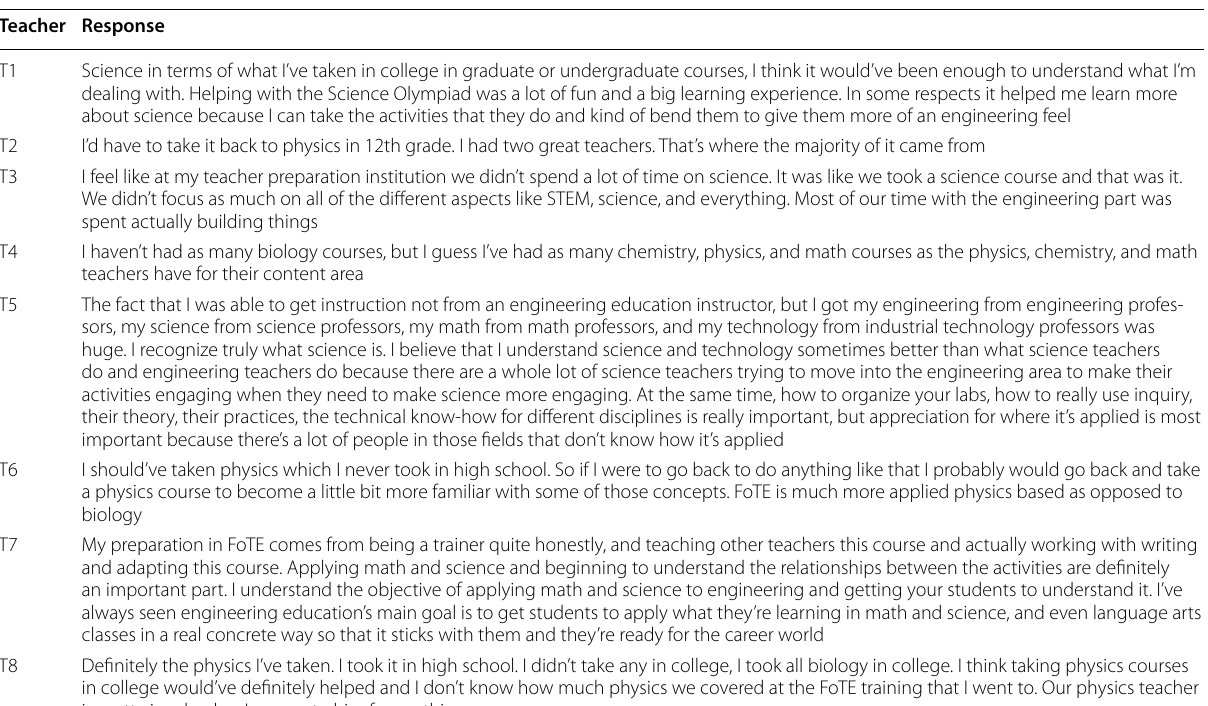
Table 9 Responses to interview questions about preparation experiences to teach engineering and interwoven science concepts Teacher